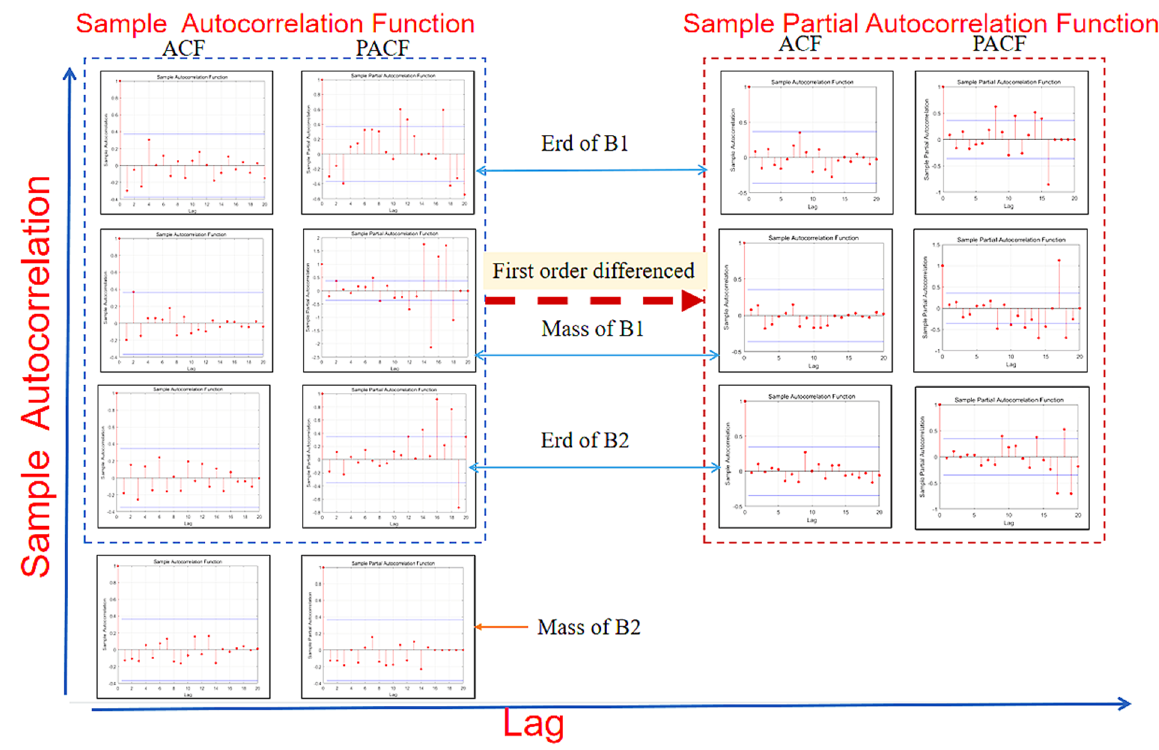
Figure 6. The initial data stability of B1 and B2 was tested by ACF and PACF test and post-difference test.